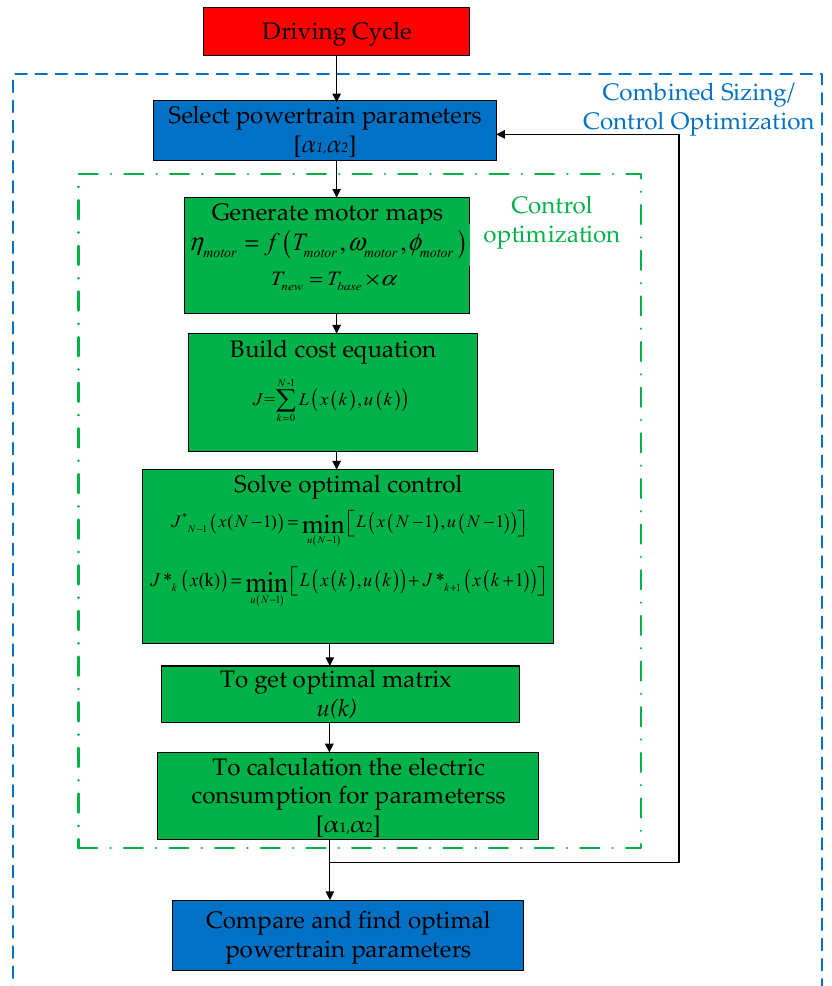
Figure 9. Flowchart of the combined power management/design optimization.